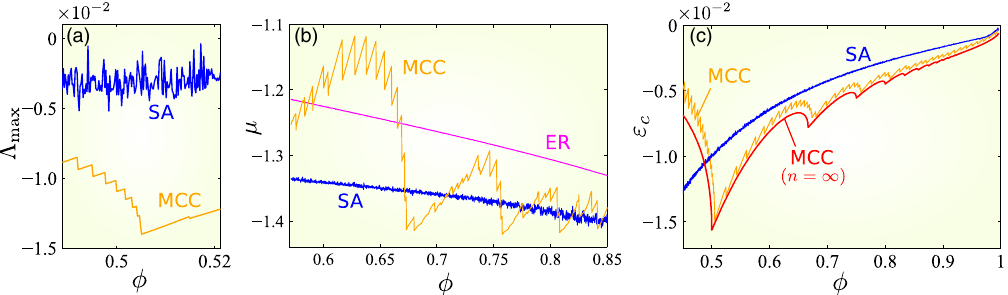
FIG. 8. Sensitive dependence on link density ϕ in physical examples of undirected networks. (a) Exponential rate of convergence Λ to a synchronous state of power-grid networks. (b) Mean finite-time convergence rate μ toward synchronization in networks of optoelectronic oscillators. (c) Critical diffusivity threshold ε c for Turing instability in networks of activator-inhibitor systems. Description of these three systems can be found in Supplemental Material [58], Secs. S1A – S1C. The orange curves indicate the values of these quantities for the MCC networks with n ¼ 100 constructed by the procedure described in Appendix C, while the red curve in (c) is the finite- n approximation obtained from the asymptotic formula in Eq. (15). The blue curves indicate the corresponding values for networks found by SA. The magenta curve in (b) is the mean value for the ER random networks estimated from 1000 realizations, while in (a) and (c) the values are relative to the corresponding mean value for the ER random networks (and thus zero corresponds to the ER mean